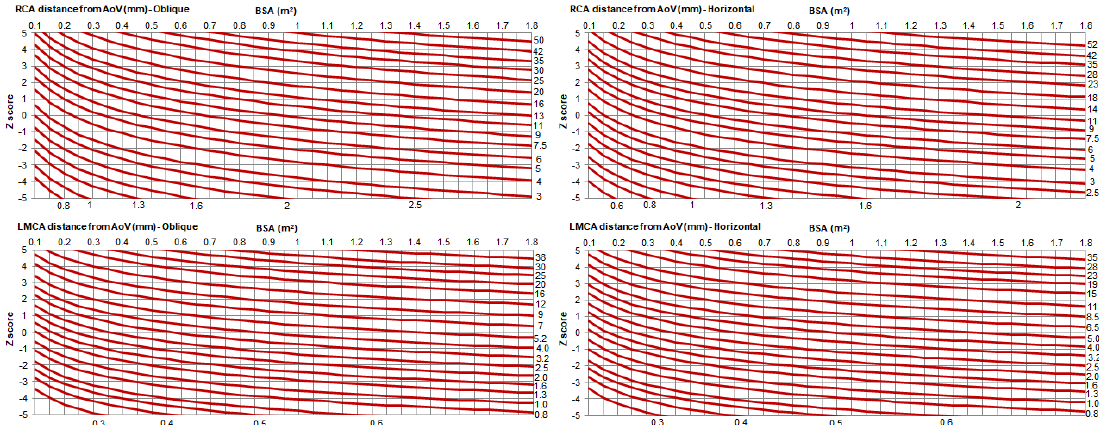
Figure 5. Predicted values and Z-score boundaries for RCA and LMCA. AoV = aortic valve, BSA = body surface area, LMCA = left main coronary artery, RCA = right coronary artery. In 12 (1.71%) healthy children, the LMCA origin was at the level of the STJ, with a mean distance of 10.03 ± 1.23 mm/m 2 from the aortic annulus and 0.19 ± 0.14 mm/m 2 from the STJ; these cases had a mean emergence angle of 131.15 ± 12.2 ◦ in the SAX. In 17 (2.43%) healthy children, the LMCA origin was above the STJ, with a mean dis- tance of 2.65 ± 4.3 mm/m 2 . In these cases, the mean emergence angle was 129.34 ± 18.45 ◦ in the SAX. In three of these cases, the LMCA origin was >120% of the distance from the Ao annulus to the STJ in the LAX. Among these 17 patients, none had a slit-like origin, whereas a minor luminal narrowing was present in all of these cases to varying degrees (mean: 22.14 ± 11.8%; range: 17.2–37.2%). Data are summarized in Table